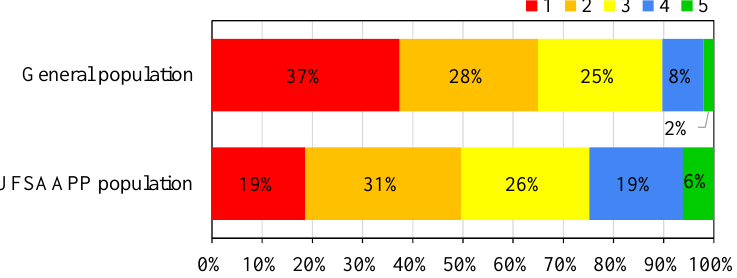
Figure 8. Level of how much citizens feel informed about air quality in their area of residence, ranging from 1 (“not at all”) to 5 (“very